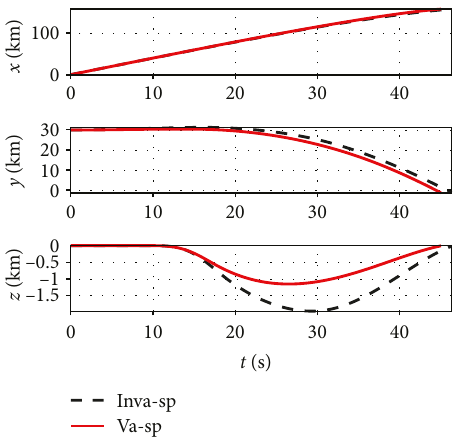
Figure 9: Curves representing the missile ’ s position projected onto the launch coordinate frame. Inva_sp: invariable span; Va-sp: variable span.